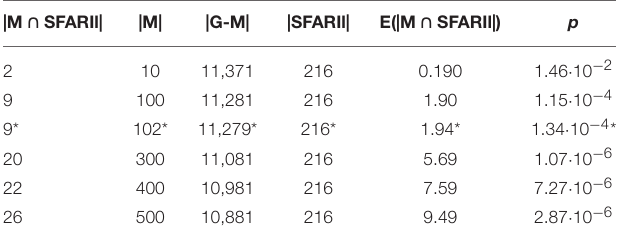
Frontiers in Genetics |